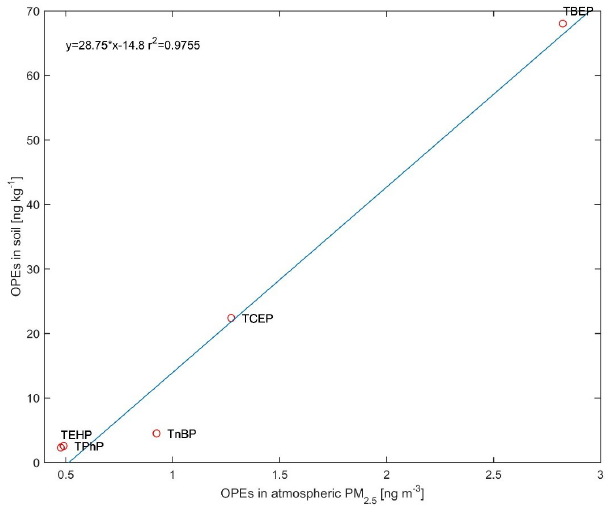
Figure 6. Relationship between OPEs in atmospheric PM 2 . 5 and in